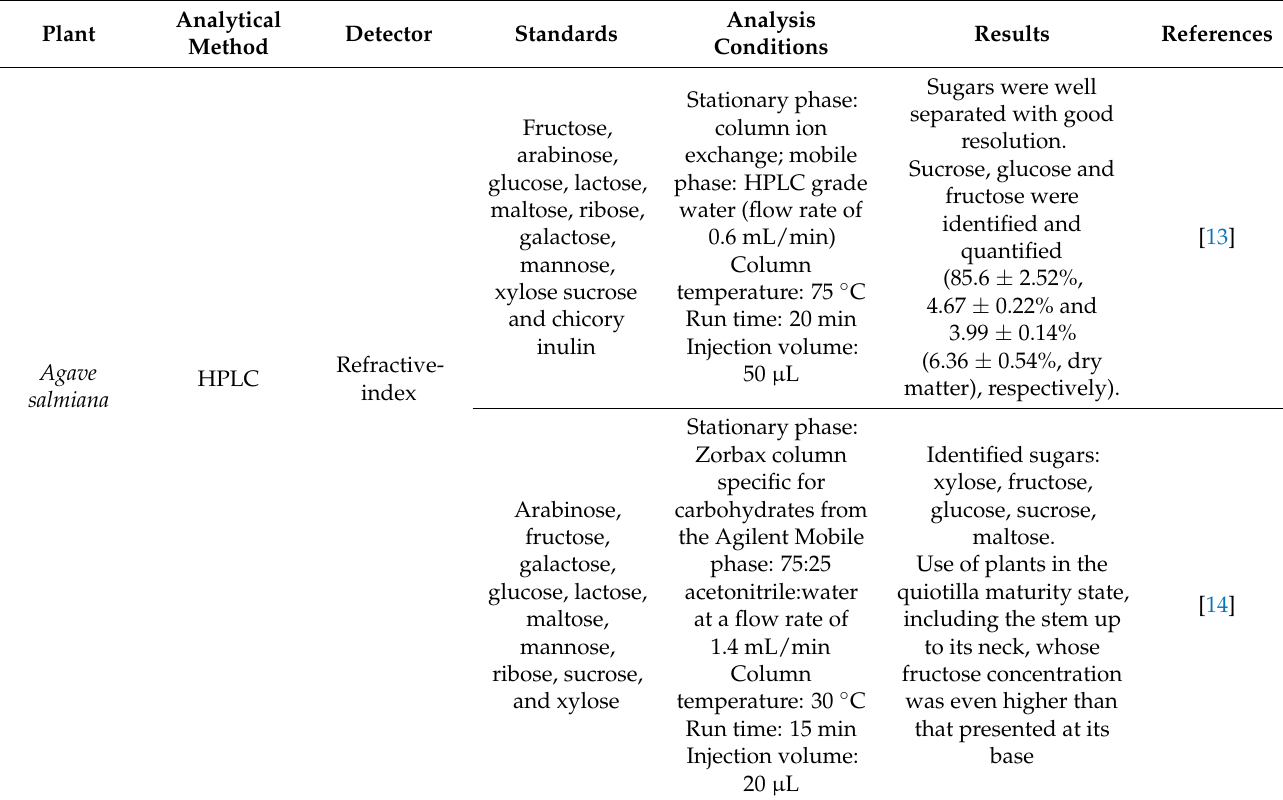
Table 1. Analytical methods for the characterization of agave syrup